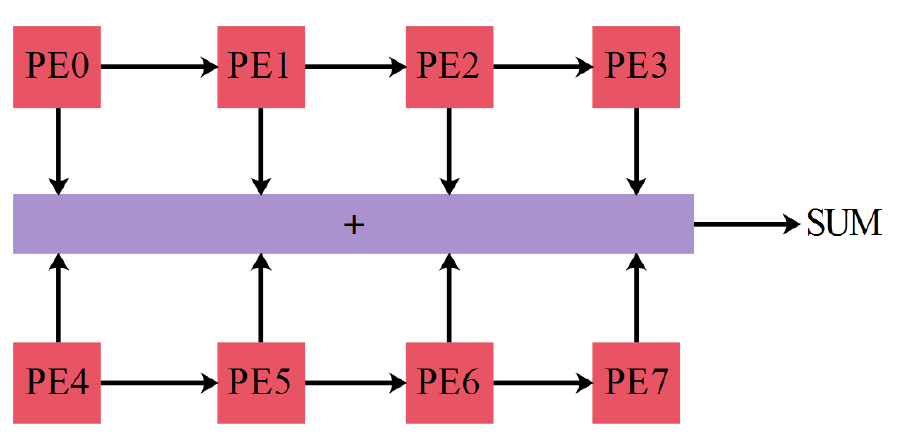
Figure 4. Convolutional operation of 7 × 7. Table 1. P eak multiplier utilization for various kernel sizes.